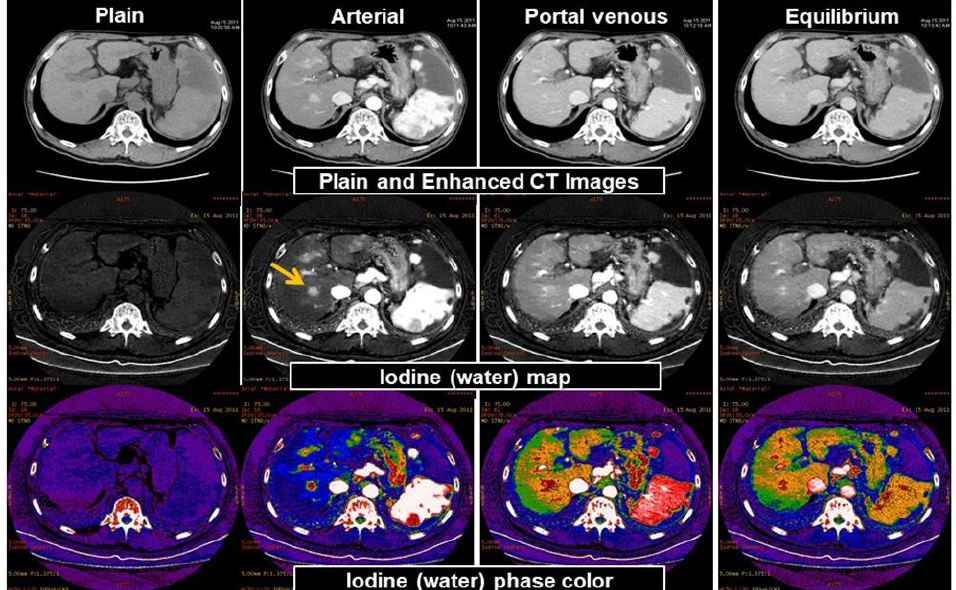
Figure 5. Hepatocellular carcinoma. Dynamic CT (upper panel), iodine density image (middle panel), iodine density color image (lower panel). Hepatocellular carcinoma deeply stained in the arterial phase of dynamic CT is recognized. Density iodine imaging clearly shows tumor staining. Density iodine color imaging shows tumor deeply stained by arteries and iodine distribution in the hepatic parenchyma deeply stained by portal blood flow.